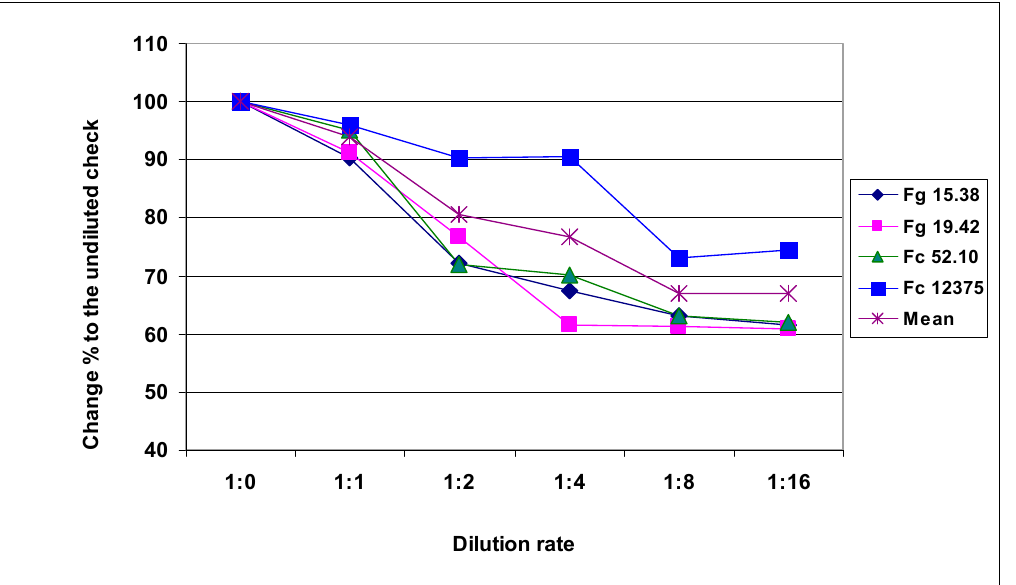
Figure 1. Reduction of the aggressiveness of Fusarium graminearum and Fusarium culmorum isolates at di ff erent dilution rates, visual symptoms, DI%, across genotypes, 100 = undiluted inoculum, 2013-2014.